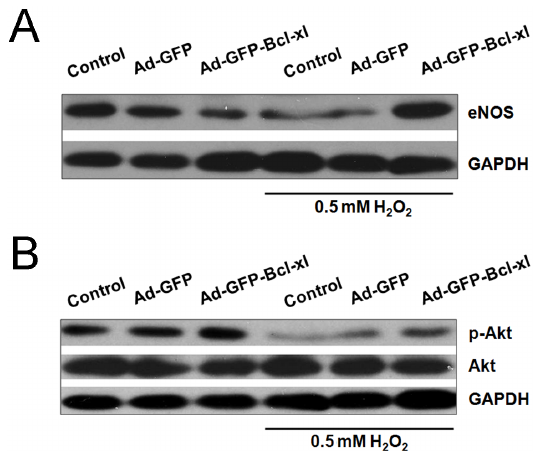
Figure 4. The effects of Bcl-xl overexpression on Akt phosphorylation and eNOS protein O -stimulated HUVECs. After being infected with Adv-GFP- Bcl-xl levels in H 2 2 (or Adv-GFP) of 100 MOI for 48 h, HUVECs were subsequently stimulated with 0.5 mM O for 12 h. Equal amounts of protein were resolved by SDS-PAGE followed by H 2 2 Western blot analysis with antibodies against each specific protein. ( A ) Western blotting for the measurement of eNOS protein levels in HUVECs; ( B ) Western blotting for the measurement of Akt and p-Akt protein